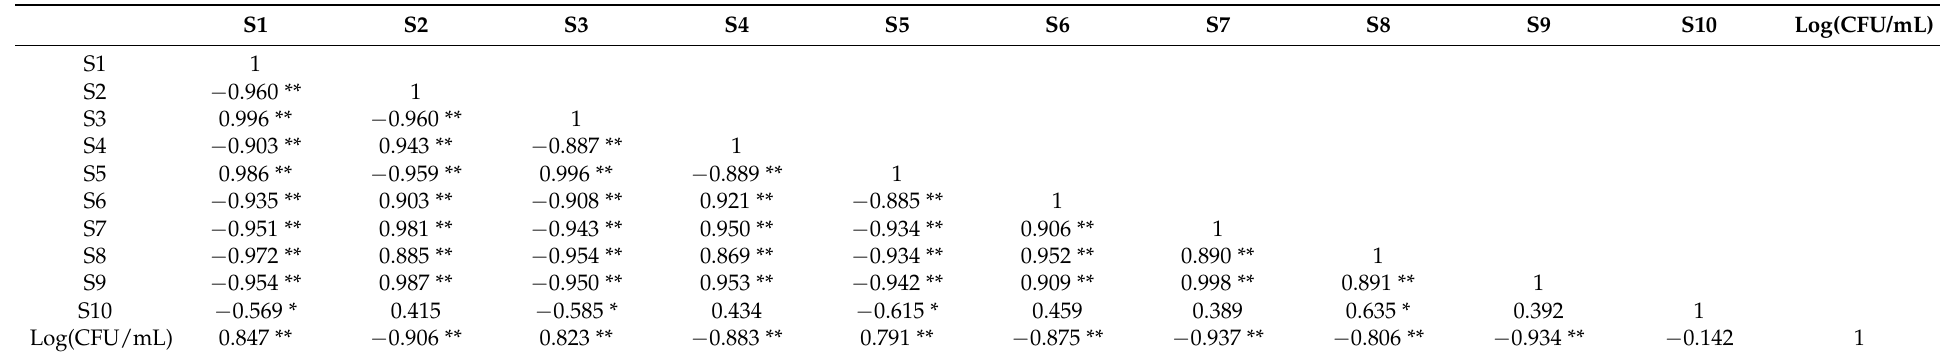
Table 4. Pearson correlation analysis between the E-nose response values and the total bacterial count of freshly squeezed strawberry juice during cold